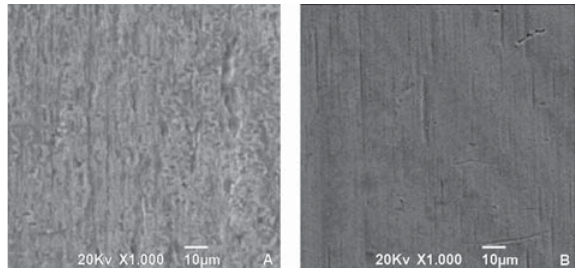
Figure 5- Scanning electron microscopy micrograph showing surface topography of SS wire (associated with MB) before (A) and after (B) mechanical traction